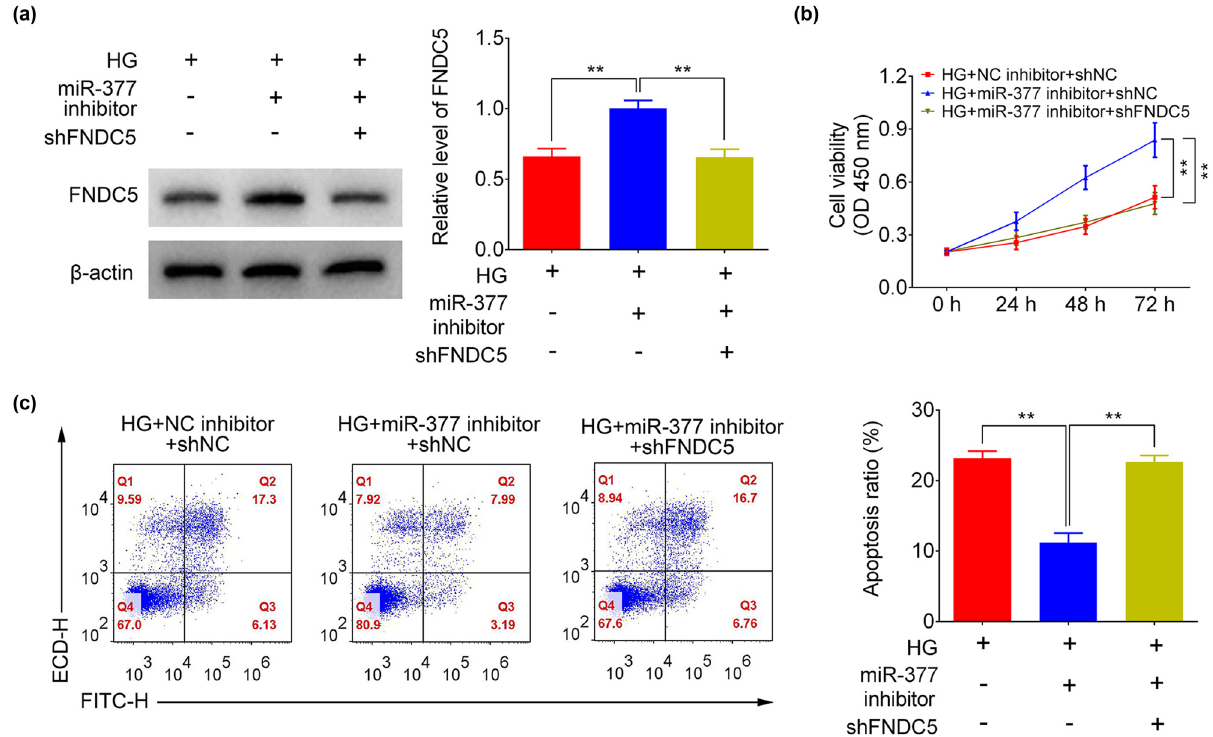
Figure 5: FNDC5 downregulation abolished the e ff ects of miR - 377 - 3p on cell proliferation and apoptosis. ( a ) Protein expression levels of FNDC5 in HTR - 8/SVneo cells from groups of HG, HG + miR - 377 - 3p inhibitor, HG + shFNDC5, or HG + miR - 377 - 3p inhibitor + shFNDC5, as determined using western blotting. Bands were quanti fi ed and shown in histogram. ( b ) Cell growth curves of HTR - 8/SVneo cells from groups of HG, HG + miR - 377 - 3p inhibitor, HG + shFNDC5, HG + miR - 377 - 3p inhibitor + shFNDC5. ( c ) Apoptosis analysis of HTR - 8/SVneo cells ( control or HG ) and HG cells from groups of HG, HG + miR - 377 - 3p inhibitor, HG + shFNDC5, HG + miR - 377 - 3p inhibitor + shFNDC5. Apoptosis rates were quanti fi ed and shown as histograms. The data are expressed as mean ± SEM; ** indicates p <